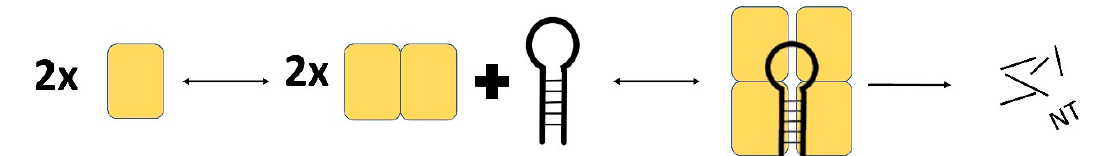
Figure 4. Schematic presentation of the ternary complex model of MCPIP1. Based on the size exclusion chromatography results Wilamowski et al. proposed a sequential binding model: oligo + MCPIP1 dimer + MCPIP1 dimer ⇄ oligo-MCPIP1 dimer + MCPIP1 dimer ⇄ oligo-MCPIP1 tetramer (MCPIP1 marked as a yelow box). MCPIP1 degrades RNA molecules as a tetramer [31].